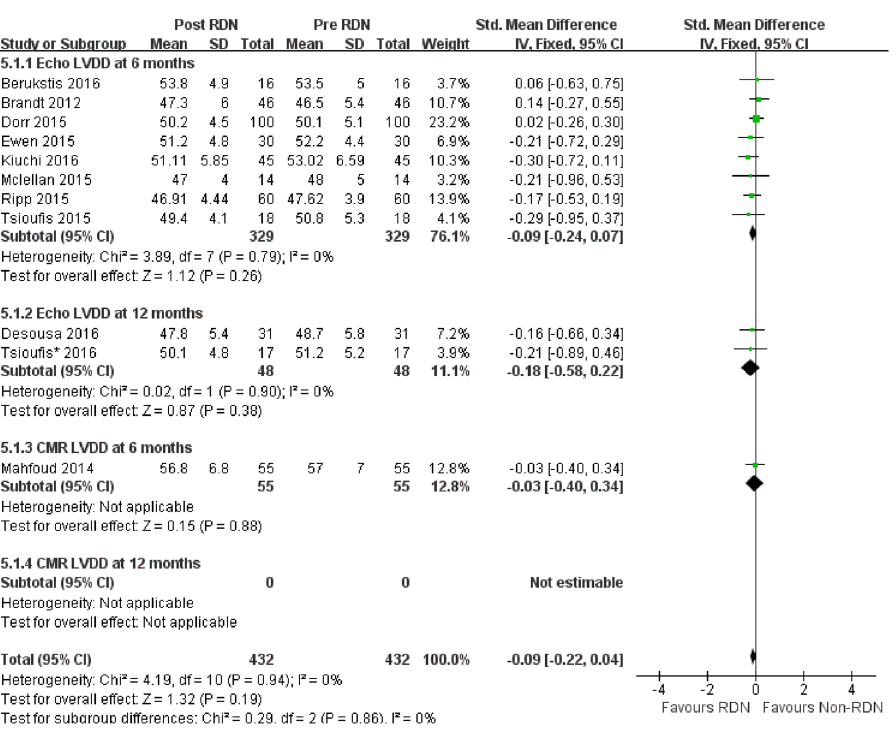
Figure 4. Forest plot of RDN changing LVDD in observational studies, stratified by follow up duration and